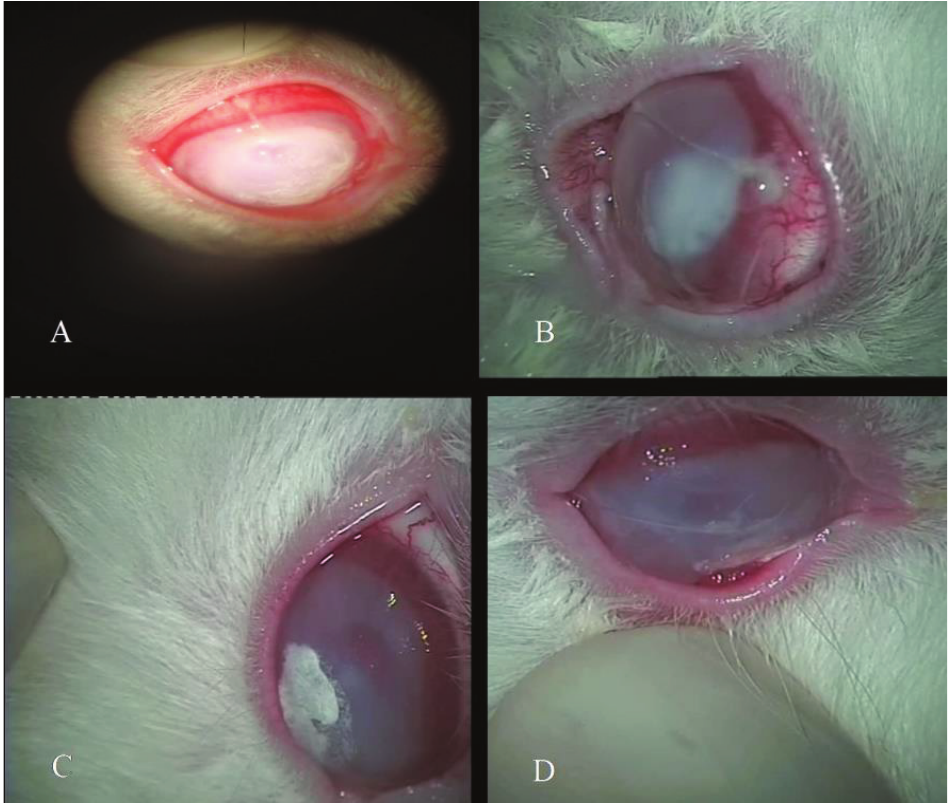
Table 1. Clinical results of four groups on the first, third, and seventh day and in the first 20 hr* Groups/days First day Third day Seventh day Control Average infiltration 2.25 mm with Average infiltration 7.01 mm with Average infiltration 23.75 mm corneal opacity and without corneal opacity, epithelial defect, with corneal opacity and epithelial defect and descemeto cell Average infiltration 2.62 mm and and